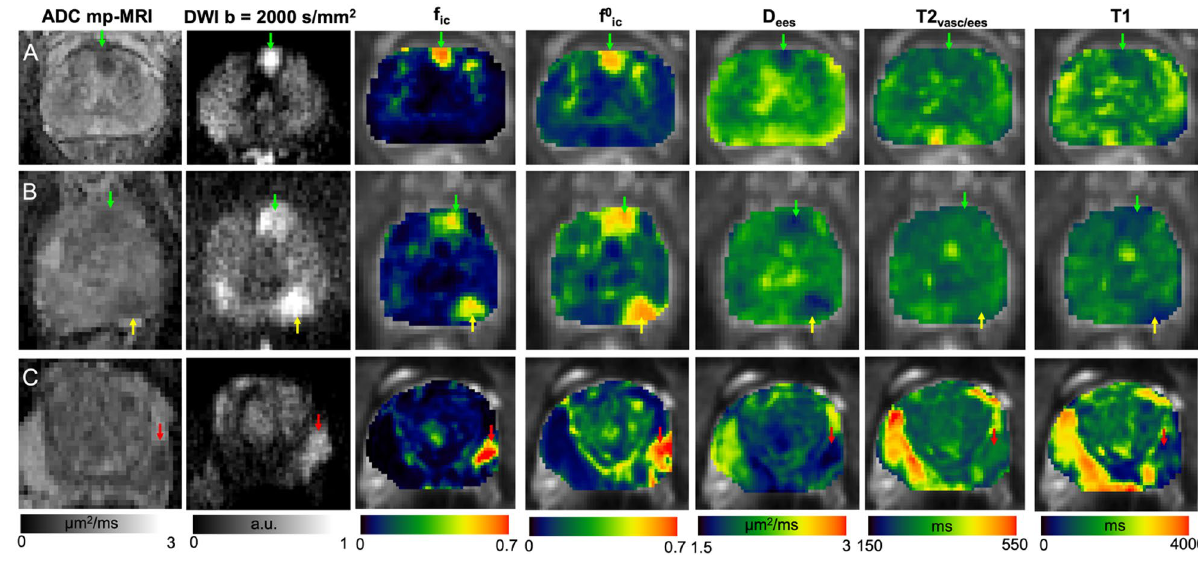
Figure 7. ( A – C ) Apparent diffusion coefficient (ADC) maps from multi-parametric MRI (mp-MRI); diffusion- weighted image (DWI) at b = 2000s/mm 2 , classic VERDICT intracellular volume fraction f ic and rVERDICT 0 maps (intracellular volume fraction f ic ; extracellular-extravascular apparent diffusion coefficient D ees ; vascular/ extracellular-extravascular T2 relaxation time T2 vasc/ees ; T1 relaxation time) for three exemplar patients with different PCa: ( A ) age late 50’s, PSA 4.78 Gleason 3 + 3 MCCL 7 mm; lesion in the anterior gland; ( B ): age late 60’s, PSA 5.21 left posterior lesion Gleason 3 + 4 MCCL 14 mm, left anterior lesion Gleason 3 + 3; ( C ): age late 60’s, PSA 8.68 Gleason 4 + 3, MCCL 10 mm; lesion in the left peripheral zone. Green arrows indicate Gleason grade 3 + 3, yellow arrows Gleason grade 3 + 4 and red arrows Gleason grade 4 +